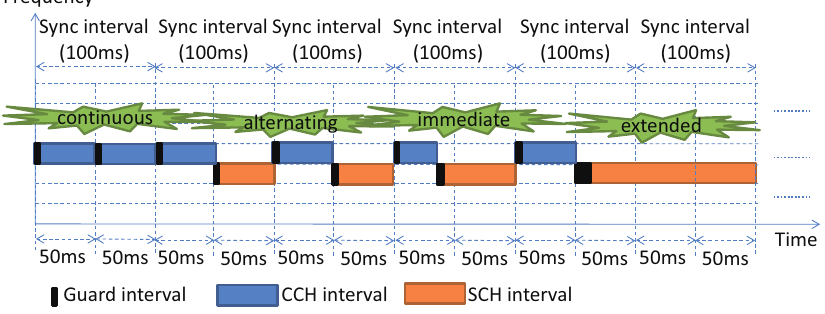
Figure 2. Standard channel access options in the IEEE 1609.4